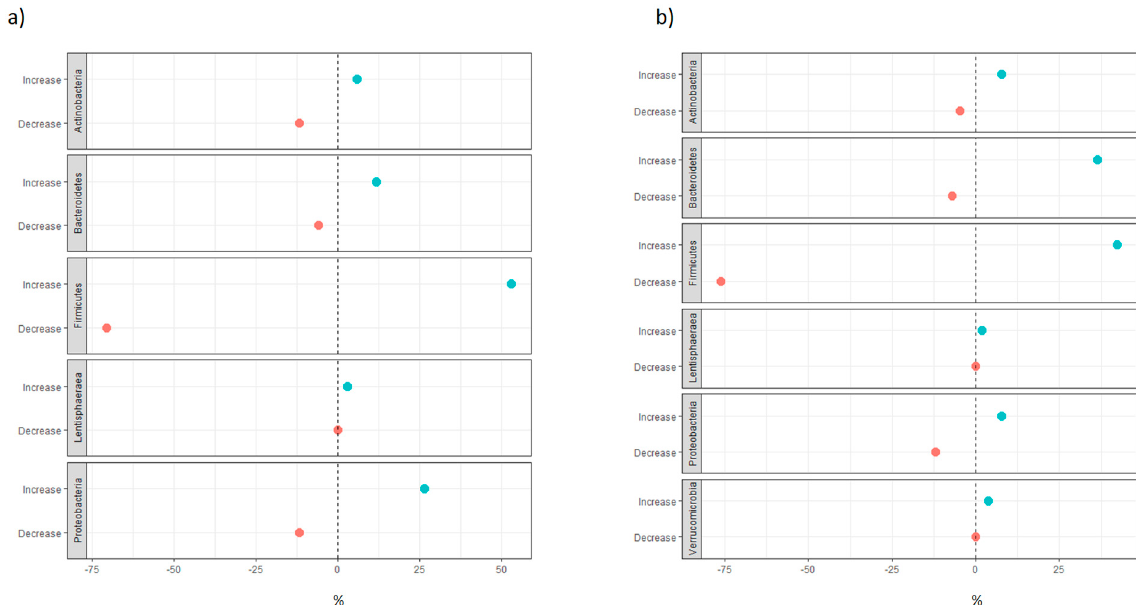
Figure 1. ( a ) For each phylum, the blue dot indicates the number of significant taxa in the phylum that increased with increasing levels of VD serum levels or dietary intake, over the total number of significant taxa that increased with increasing levels of VD serum levels or dietary intake in the non-supplementation group of studies (expressed in percentages); the red dot indicates the number of significant taxa in the phylum that decreased with increasing levels of VD serum levels or dietary intake, over the total number of significant taxa that decreased with increasing levels of VD serum levels or dietary intake in the non-supplementation group of studies (expressed in percentages). ( b ) For each phylum, the blue dot indicates the number of significant taxa in the phylum taxa that increased after VD supplementation, over the total number of significant taxa that increased after VD supplementation in the supplementation group of studies (expressed in percentages); the red dot indicates the number of significant taxa in the phylum that decreased after VD supplementation, over the total number of significant taxa that decreased after VD supplementation in the supplementation group of studies (expressed in percentages).